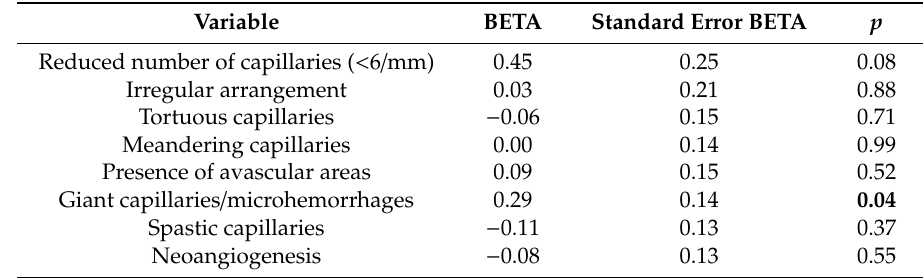
Table 9. Factors (capillaroscopic parameters) determining sE-selectin concentration in the study group (determination coe ffi cient R 2 = 0.21).